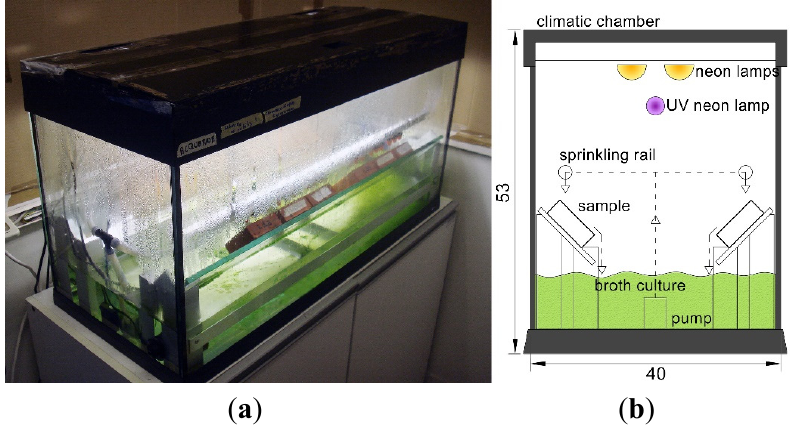
Figure 2. View ( a ) and schematic view ( b ) of test